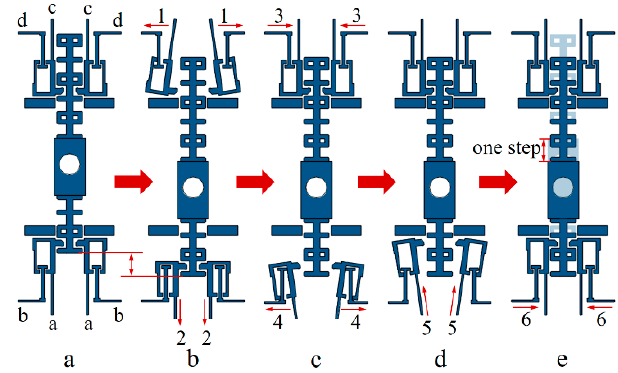
Figure 6. The operation process of S&A chip: ( a ) Initial state, the actuators are divided into four groups; ( b ) Step1, disengagement of the upper pawls and slider, and Step2, the slider is pulled by the lower pawls; ( c ) Step3, reengagement of the upper pawls and slider, Step4, disengagement of the lower pawls and slider; ( d ) Step5, the lower pawls realign with the slider; and ( e ) Step6, reengagement of the lower pawls and the slider.